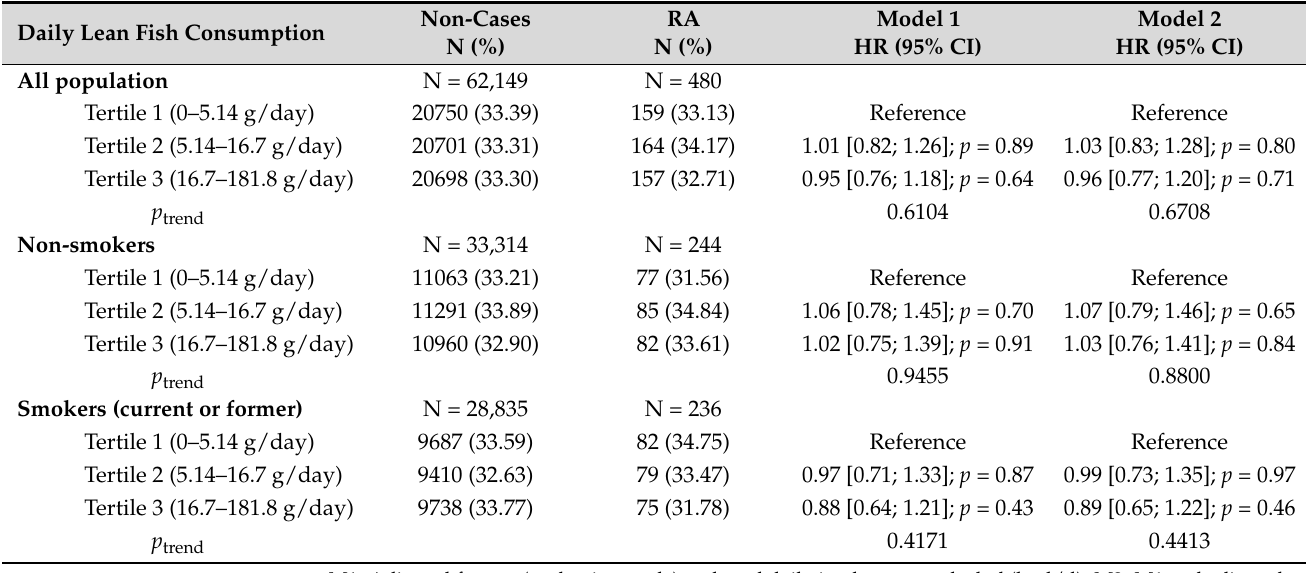
Table 3. Hazard ratios (95% confidence intervals) for the risk of rheumatoid arthritis (RA) by tertiles of lean fish consumption, including hake, pollack, common ling, dab, haddock, sole, whiting, and/or cod (N =